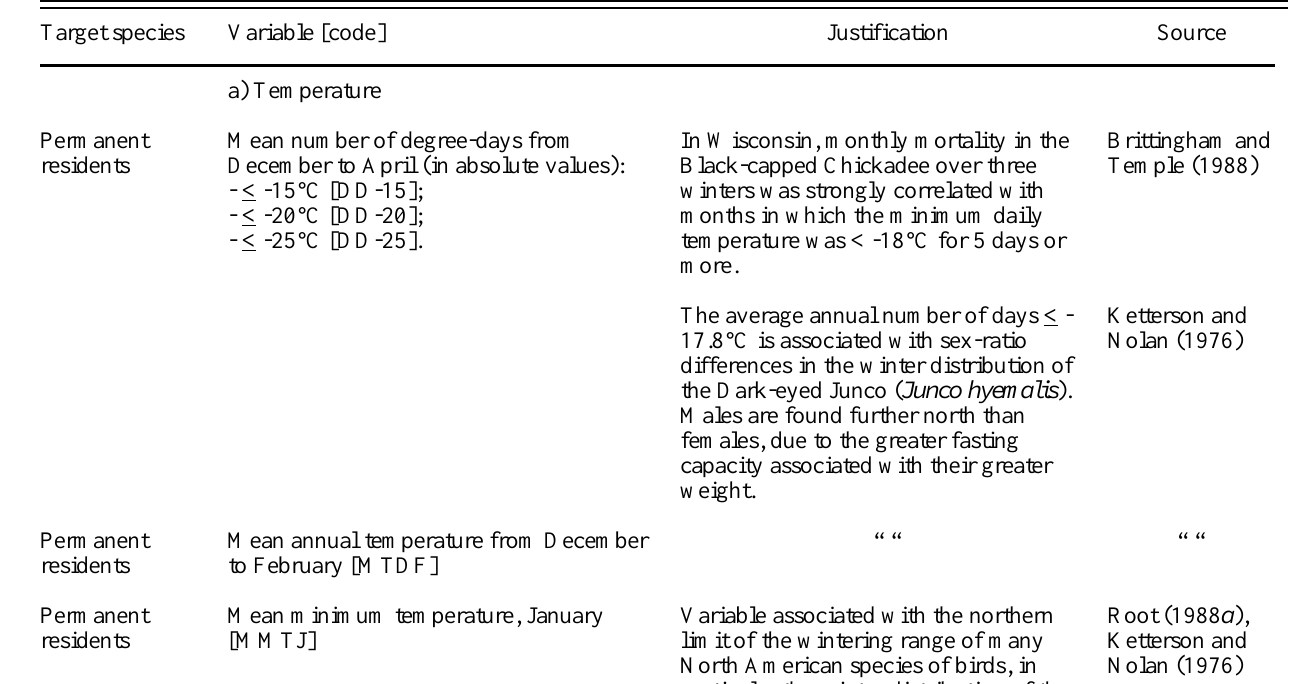
Table 2. Scoring system for daily and monthly climatic variables affecting bird sensitivity to climate.